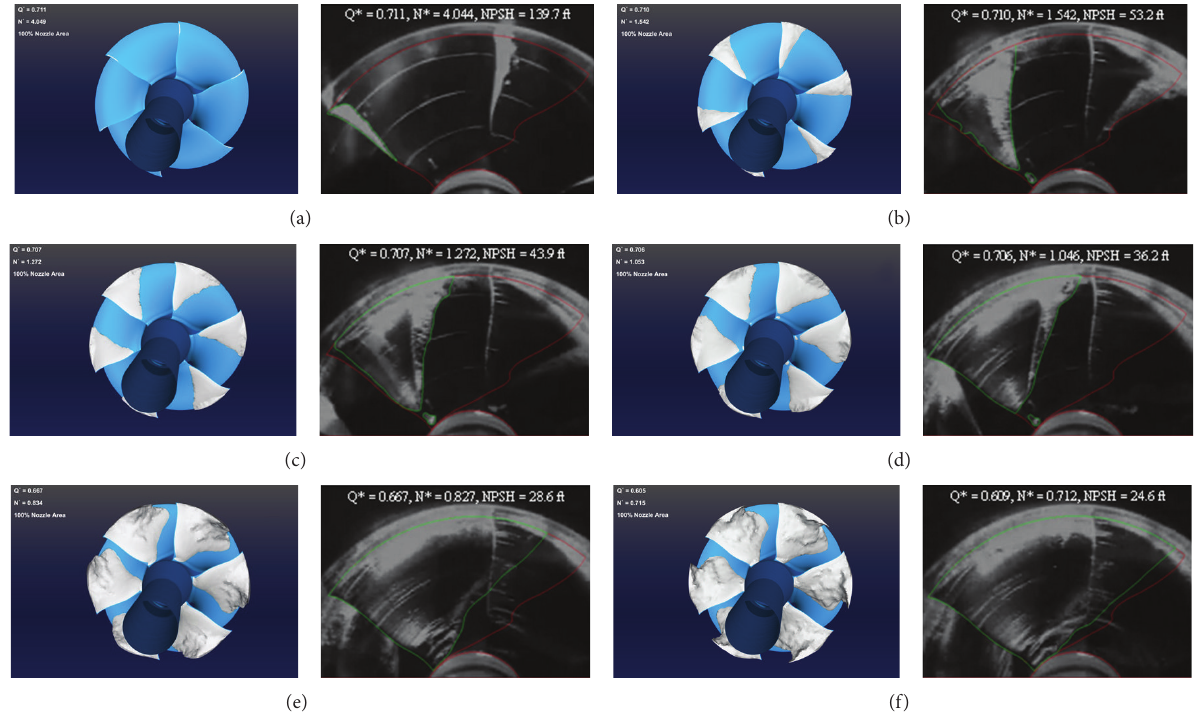
Figure 5: Predicted and observed cavitation patterns on the rotor blade (observed results obtained from [10, 11]). (a) 𝑄 ∗ = 0.711 , 𝑁 ∗ = 4.044 , NPSH = 139.7 ft; (b) 𝑄 ∗ = 0.710 , 𝑁 ∗ = 1.542 , NPSH = 53.2 ft; (c) 𝑄 ∗ = 0.707 , 𝑁 ∗ = 1.272 , NPSH = 43.9 ft; (d) 𝑄 ∗ = 0.706 , 𝑁 ∗ = 1.046 ,